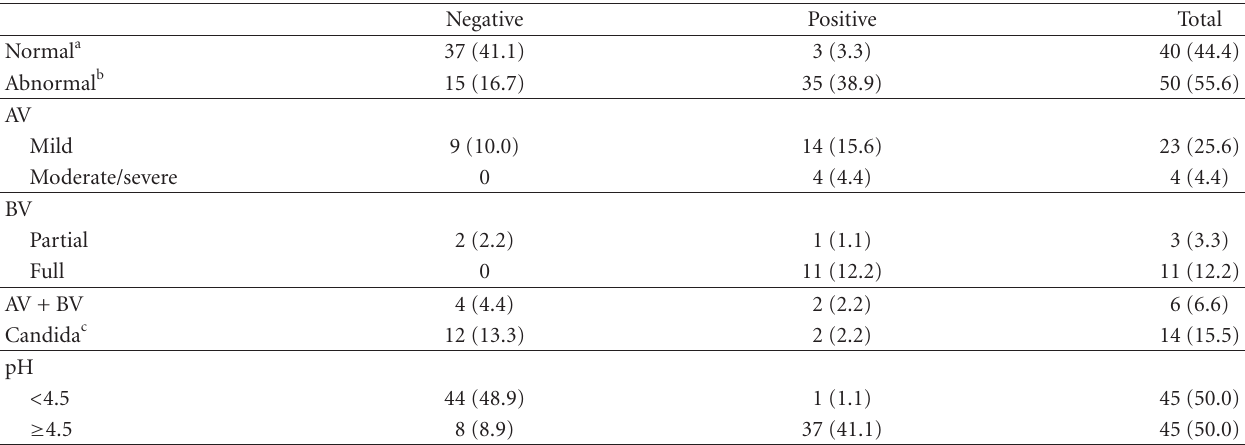
Table 4: Results of VS-SENSE test showing the number of cases according to pattern of vaginal flora presented by microscopic evaluation, Candida infection and vaginal pH